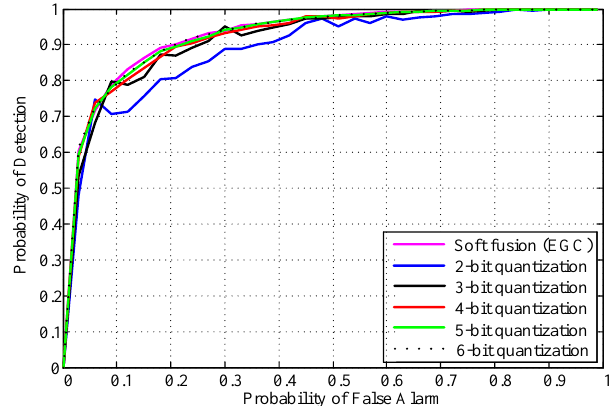
Figure 4. Receiver operating characteristics (ROC) curves of the proposed 3-bit quantization fusion scheme in comparison to the soft fusion (EGC), hard fusion (AND), hard fusion (OR), SLMC fusion, and semi-soft fusion schemes.